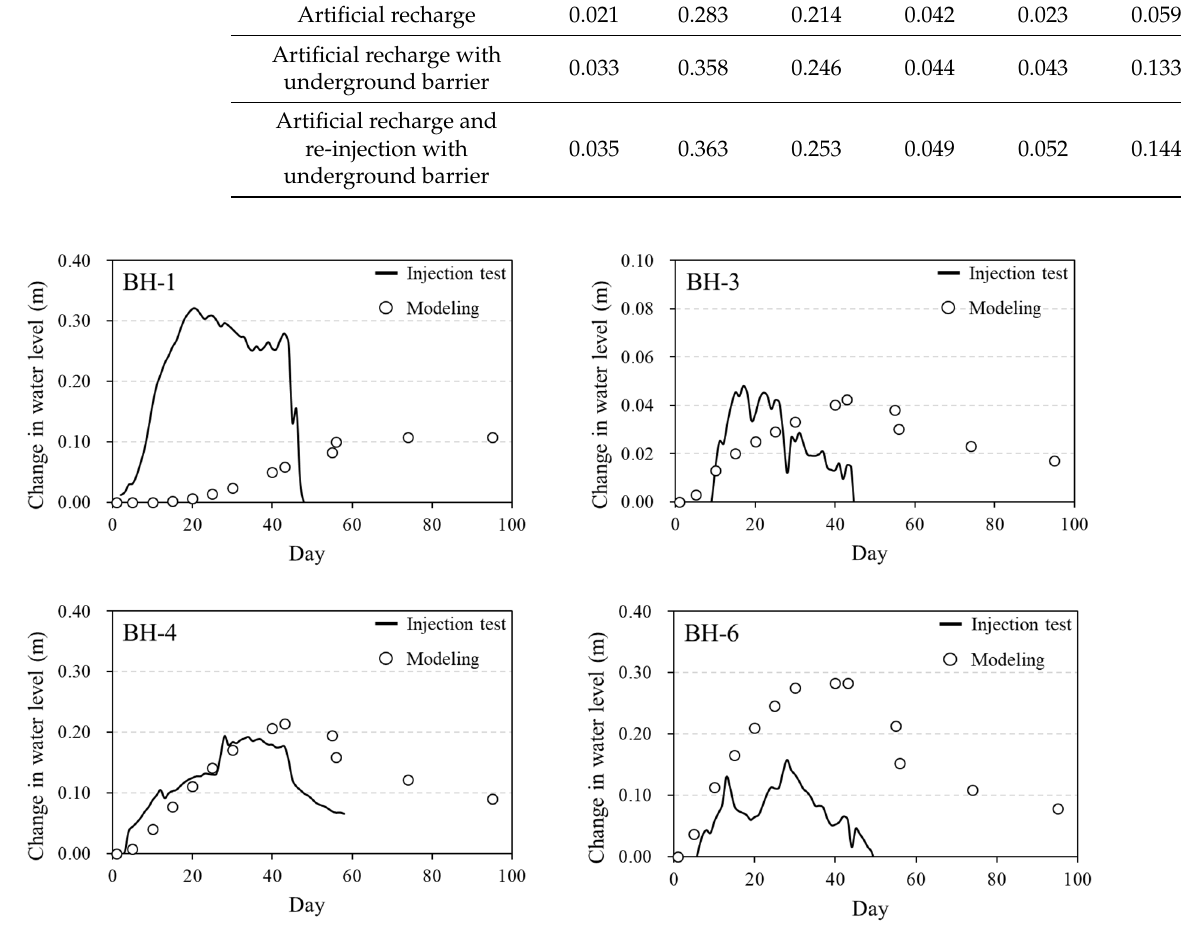
Figure 5. Comparison of actual and predicted groundwater levels after artificial recharge. Meanwhile, the effects of long-term injection were compared under steady-state con- ditions (no injection) and without underground barrier. The retention caused by injection in the recharge area increased by 98 m 3 · d − 1 , while discharge into the stream occurred simultaneously at a rate of 80 m 3 · d − 1 (Figure 6). This implies that the injected water did not stay in the recharge basin for a long time and was released into the stream. This contributed to the observed increase in stream flow, explaining the relatively slow groundwater level rise compared to the amount of water added. Therefore, installation of the horizontal pipe of the collector well through the lower layer of the stream bed would increase the total pumping rate by adding the indirect withdrawal of stream water, as designed above (see Figure